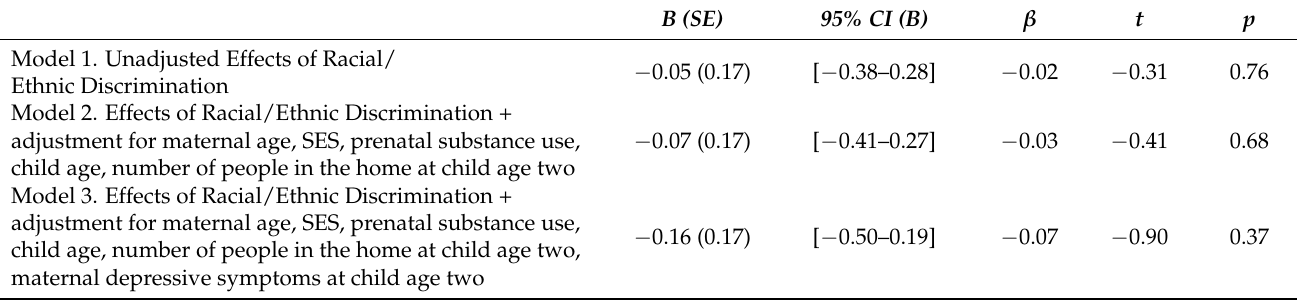
Table 3. Child sleep health at age two regressed on women’s exposure to racial/ethnic discrimination ( N =